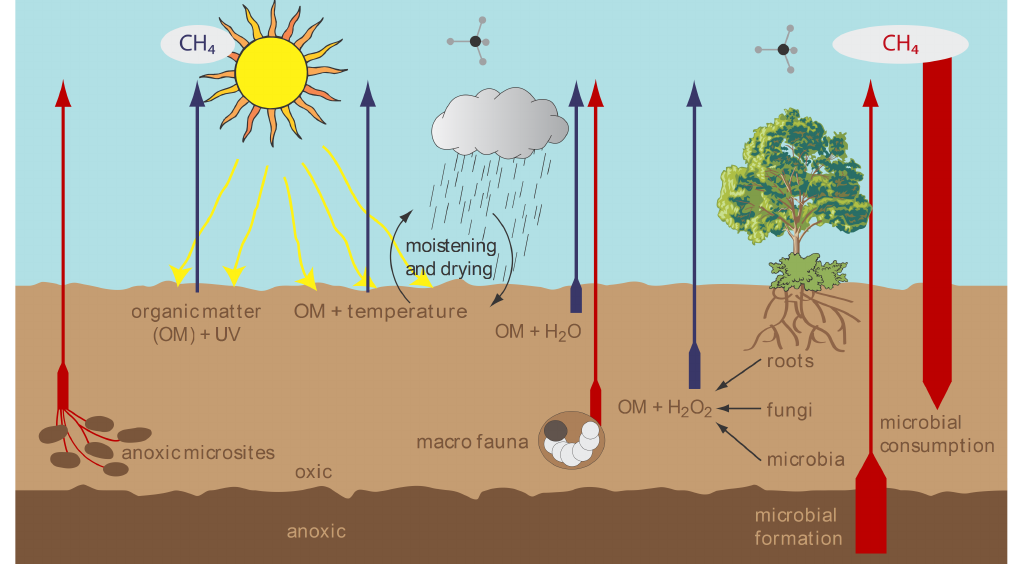
Fig. 6. Scheme of CH 4 cycling in soil including non-microbial (blue) and the previously known microbial sources (red). Environmental fac- tors such as temperature, UV irradiation, drought/wet cycles and formation of hydrogen peroxide produced by biota might control chemical formation of CH 4 in